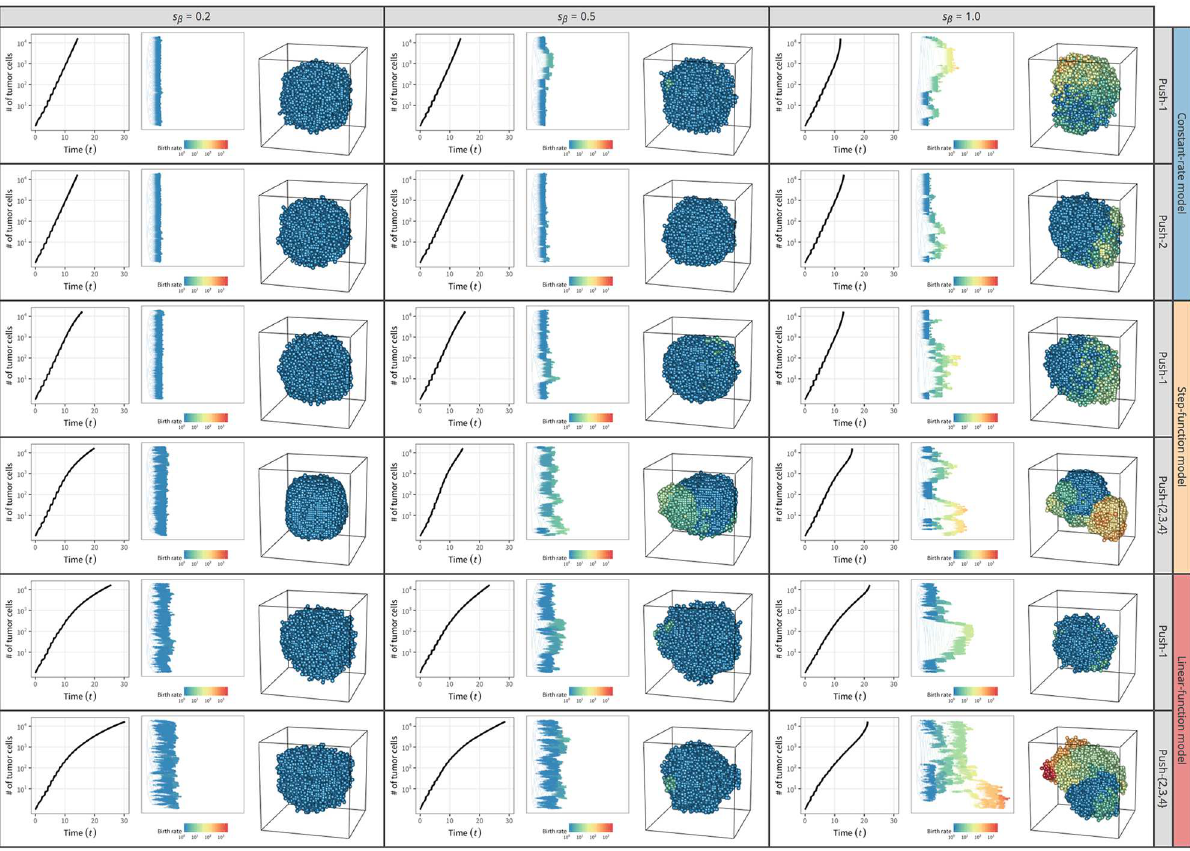
Fig 12. 3D structuresof simulated tumors with frequent weak driver mutations. Results for push methods1 and 2 under constant-rate, step-function, and linear-function models are shown; k = 100 is assumed. The colors of cells represent their cell divisionrates, scaled from blue to red. The results for one simulationrun are shown for each